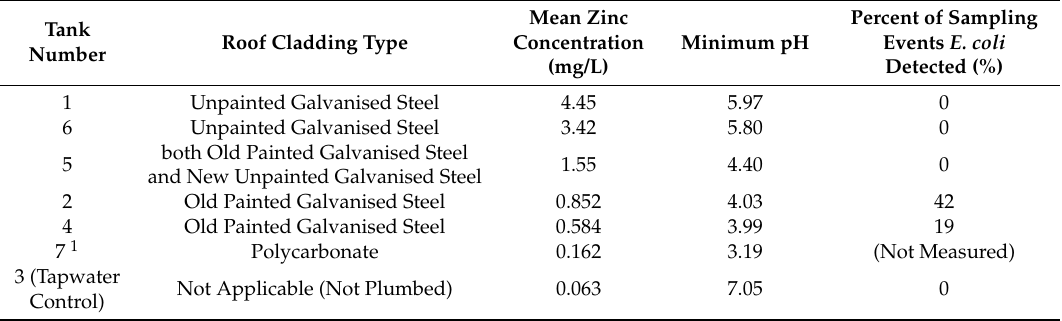
1 Refer to Supplementary Table S5 for full details of results for Tank